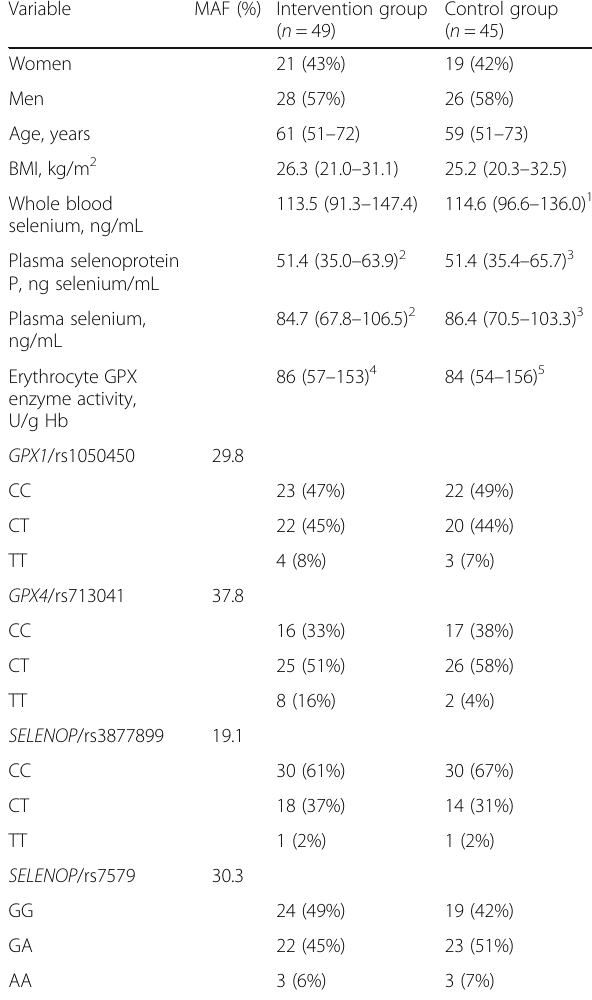
Table 1 Baseline characteristics of the participants presented as either number (%) or median value (5th – 95th percentiles)